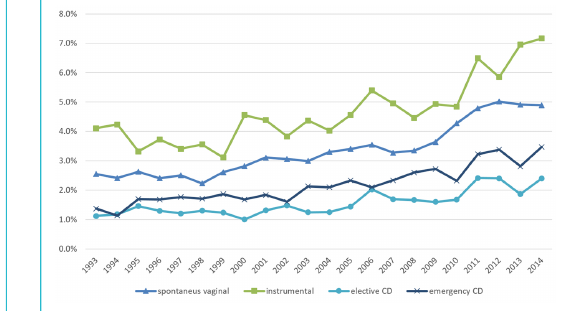
Figure 3: Postpartum haemorrhage (PPH) and delivery mode. Temporal trends in postpartum haemorrhage (PPH) rates in rela- tion to delivery mode from 1993 to 2014. Instrumental (operative) vaginal deliveries showed the highest association with PPH throughout the entire study period. CD = caesarean delivery. Y-ax- is indicates the incidence (in %) and x-axis shows the correspond- ing